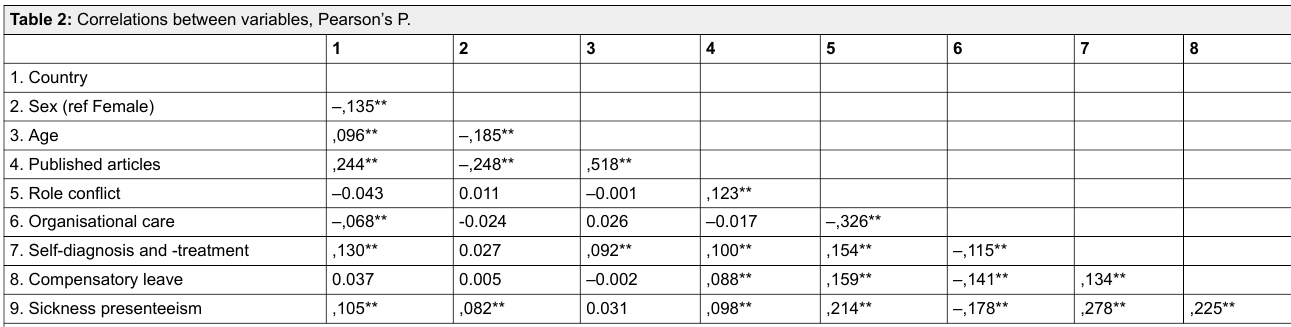
Table 2: Correlations between variables, Pearson’s